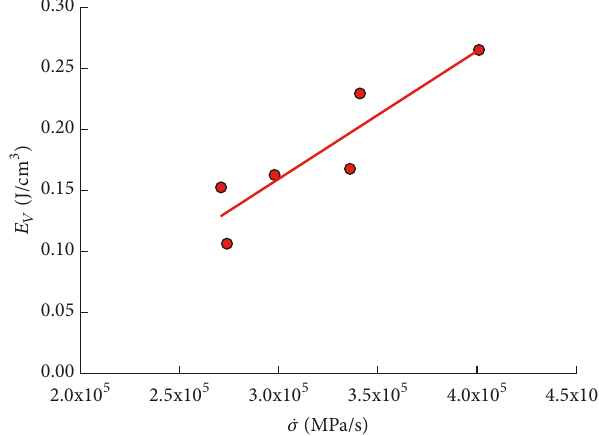
Figure 13: Unit volume absorption energy under different loading